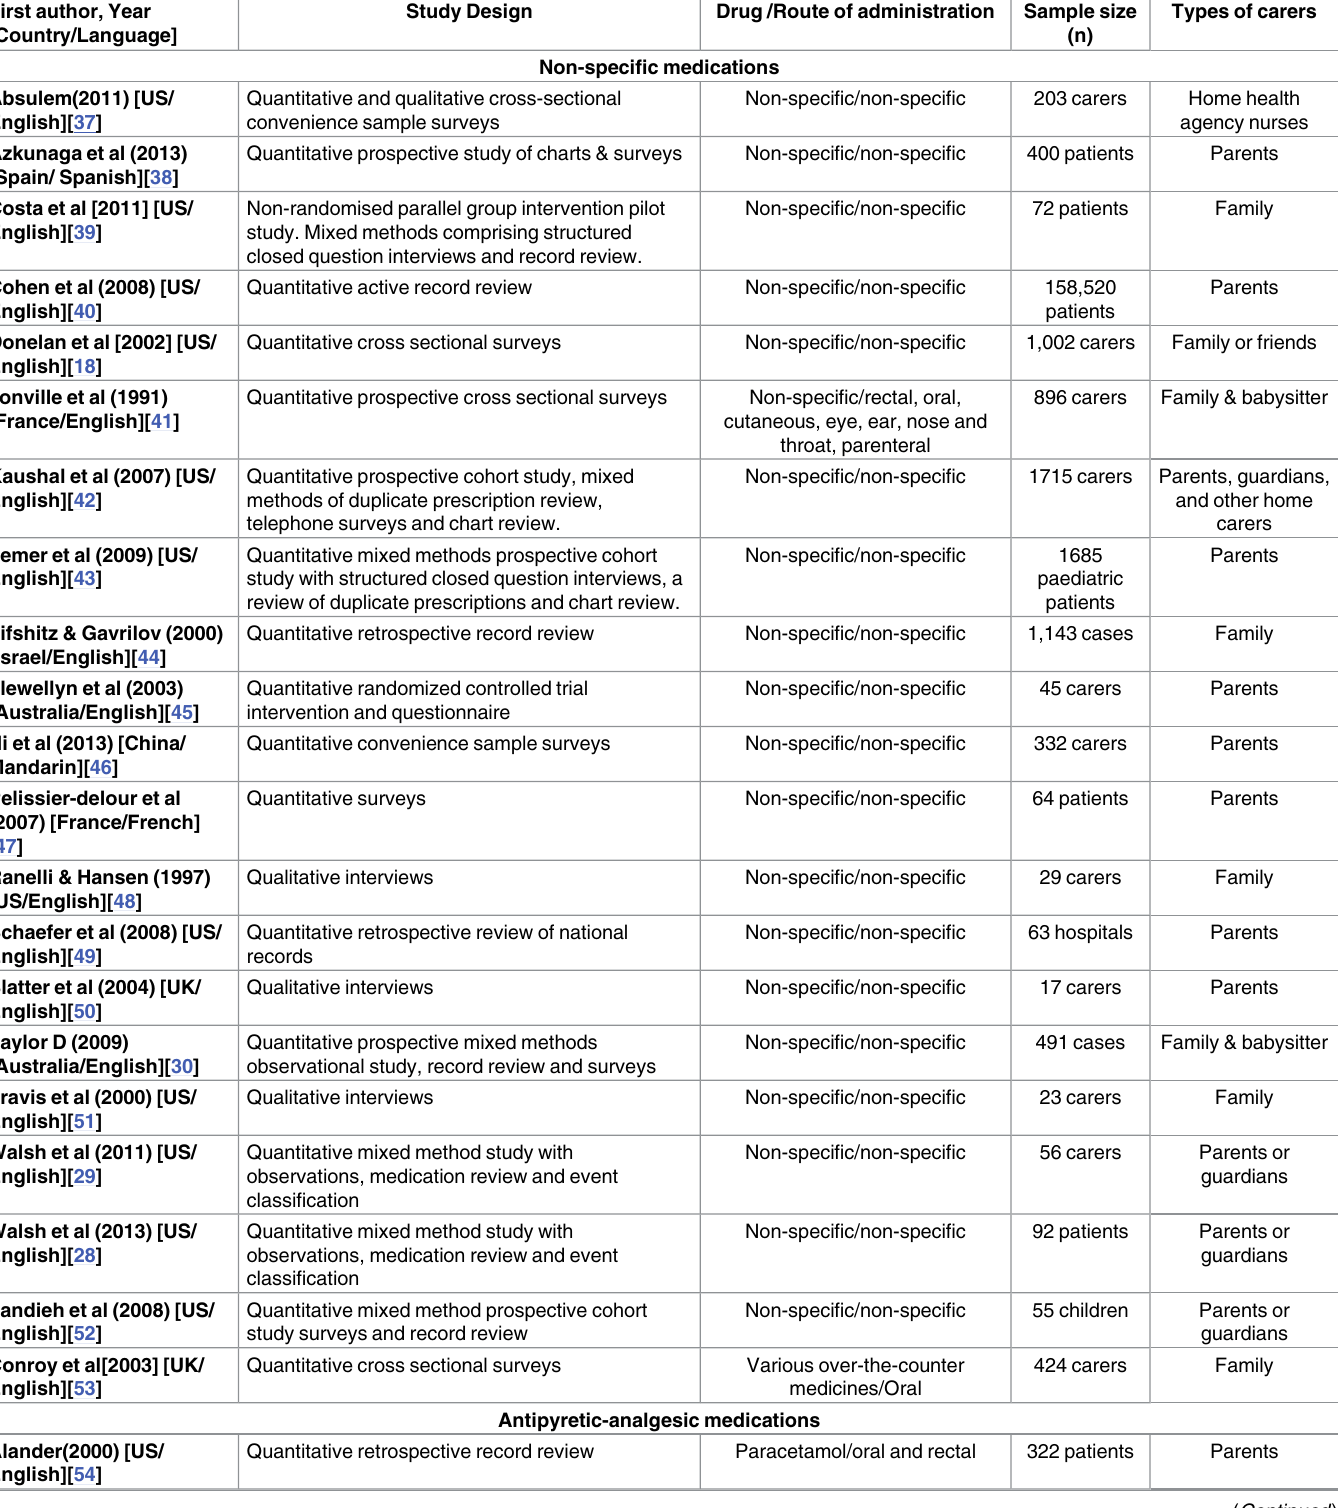
Table 1. Characteristics and summary findings of included studies First author, Year